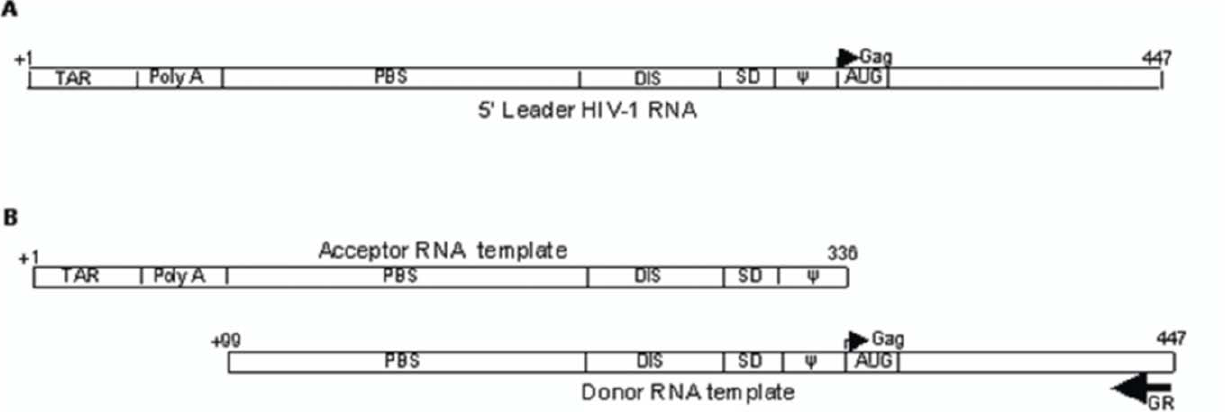
Figure 2. Schematic representation of RNA transcripts showing motifs within the 5 9 UTR of HIV-1 RNA genome. (A)5 9 leader HIV-1 RNA transcripts including the 5’ end of the gag gene (position + 1 to 447 relative to the transcriptional start site + 1). (B) Acceptor and donor RNA templates used in the template-switching assays.